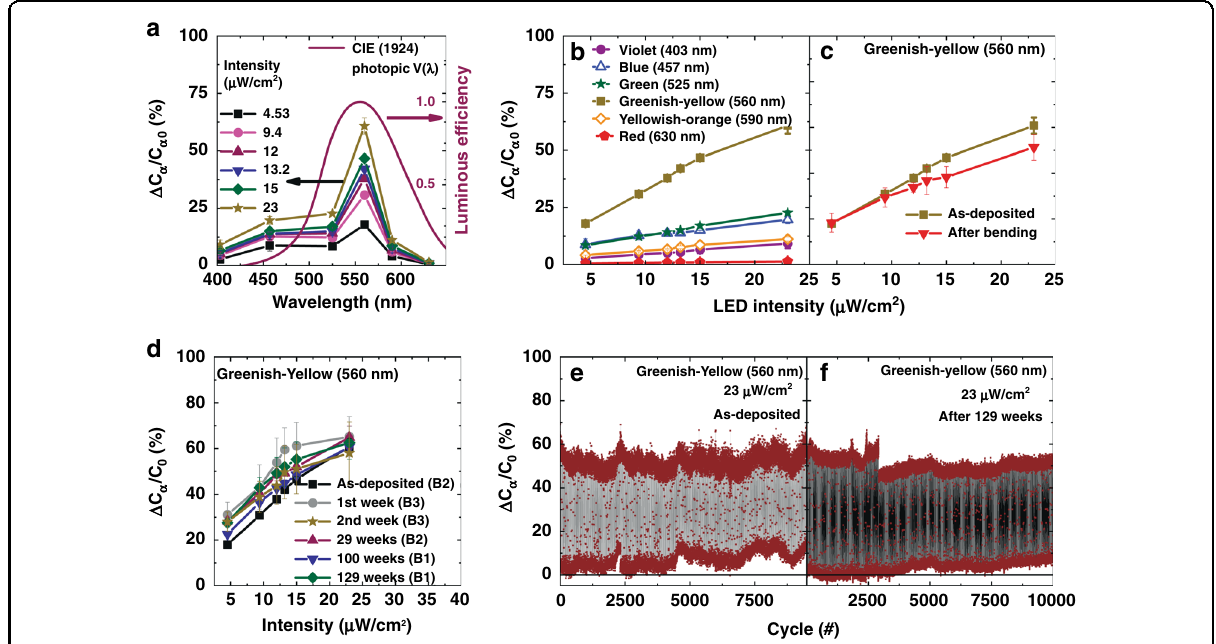
Fig. 5 Wavelength-dependent characteristics and reliability of capacitive photoreceptors (CPRs). a The variation in C α to various exciting light wavelengths, and comparison of the photo-response of the CPR with the CIE (1924) photopic luminous ef fi ciency function of human eye (data is obtained from public database available at http://www.cvrl.org). b The linear response of multiple CPRs proportional to the intensity of the light, and it shows the higher sensitivity to greenish-yellow light (560 nm), c the response and performance of fl exible CPRs without bending and after bending (bent radius ~1 cm). d The response of fabricated CPRs measured at various intervals after the devices ’ fabrication, and the response shows the devices are stable in air at least for 129 weeks after fabrication. The devices were stored in the petri dish and in-room temperature ambience (~23 °C and 40% RH). The endurance of devices; e as-deposited, f 129 weeks after fabrication measured under the excitation of modulating LED light pulses (Greenish yellow, 560 nm, 23 mW/cm2, LED on time is 10 s and OFF time is 5